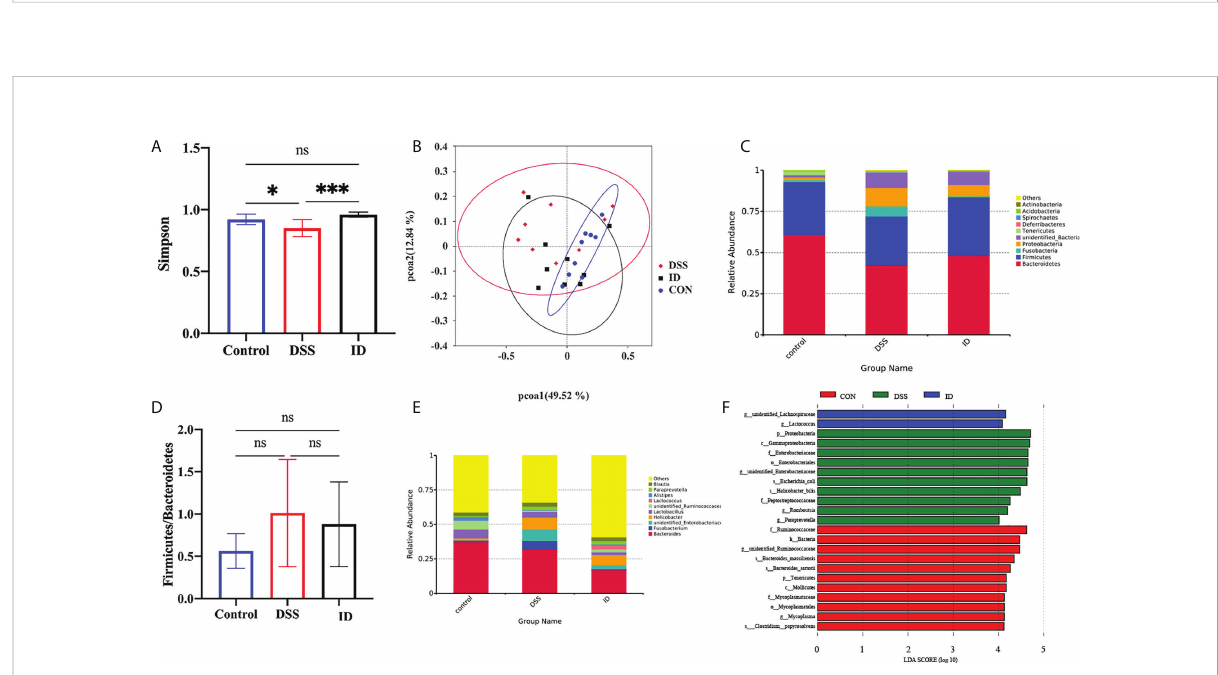
FIGURE 6 IPA modulated the composition of the gut microbiota in DSS-treated mice. (A) Index-group Difference Test of Simpson index in Sample Hierarchical Cluster Tree alpha-Diversity. Classi fi cation level: OTU. (B) Graph of principal component analysis (PCoA) at the genus level. (C) Microbial community bar plot at the phylum level with the relative abundance within the top 10. (D) Microbial community bar plot at the genus level with the relative abundance within the top 10. (E) Ratio of the percentage of 16S rRNA gene sequences assigned to Firmicutes versus Bacteroidetes. (F) Latent Dirichlet allocation (LDA) score distribution histogram and cladogram. P<0.05(*), P<0.05 (*), P<0.01